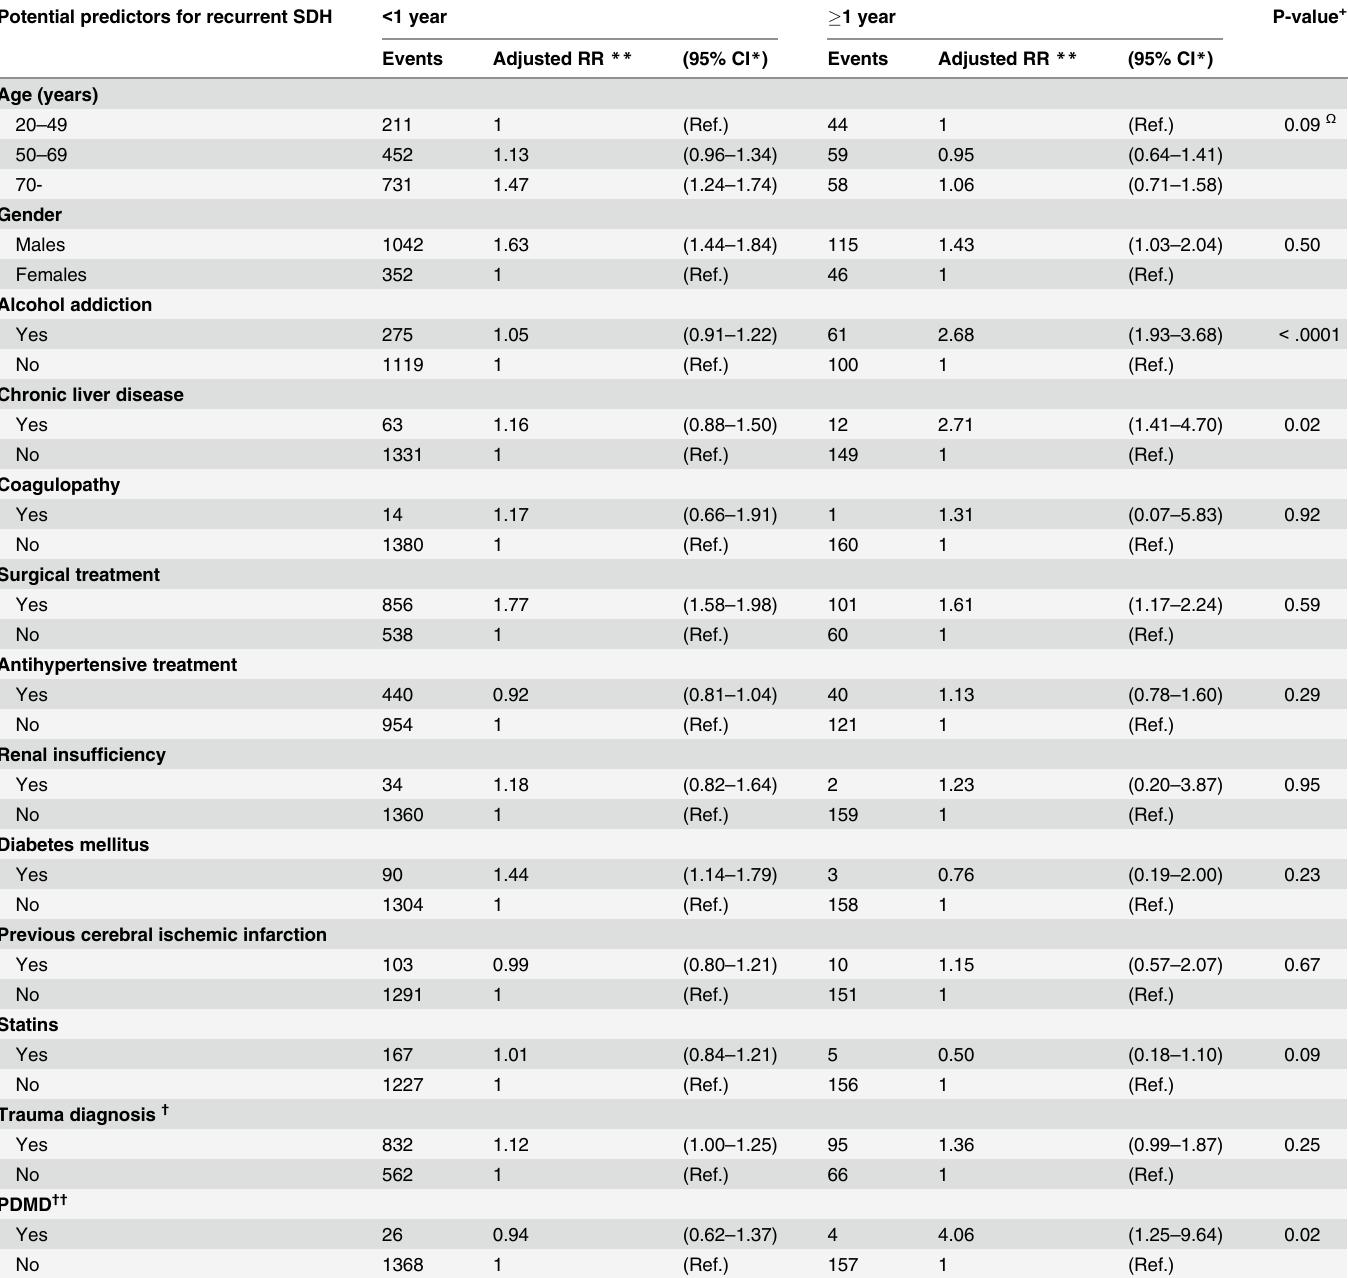
Table 2. Rate ratio (RR) of recurrent subdural haematoma (SDH) within the first year and after the first year of follow-up, according to concomitant medical diseases and other potential predictors in Denmark 1996 – 2011. Potential predictors for recurrent